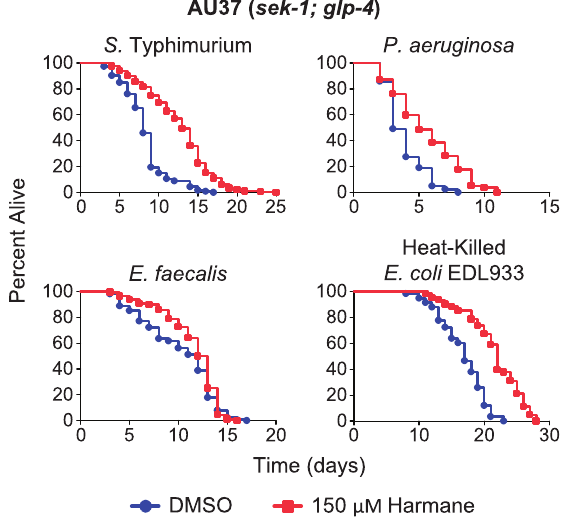
Figure 2. Harmane rescues sek-1 ; glp-4 nematodes fed on different pathogens. There was a significant extension of life span of C. elegans feeding on bacteria grown on Harmane plates compared to plates with DMSO. The median survival when fed on S . Typhimurium was 8 days on DMSO and 13 days on 150 m M Harmane [ P , 0.0001; DMSO, n=113; 150 m M Harmane, n=180]. When fed on P. aeruginosa on DMSO, median survival was 3 days, and on 150 m M Harmane it was 5 days [ P , 0.0001; DMSO; n=120; 150 m M Harmane, n=134]. Feeding on E. faecalis on DMSO resulted in a median survival of 12 days, compared to 12.5 days on 150 m M Harmane [ P =0.0013; DMSO, n=162; 150 m M Harmane, n=198]. When feeding on heat-killed E. coli EDL933, the median survival was 17 days on DMSO, compared to 22 days on 150 m M Harmane [ P , 0.0001; DMSO, n=58; 150 m M Harmane, n=61].